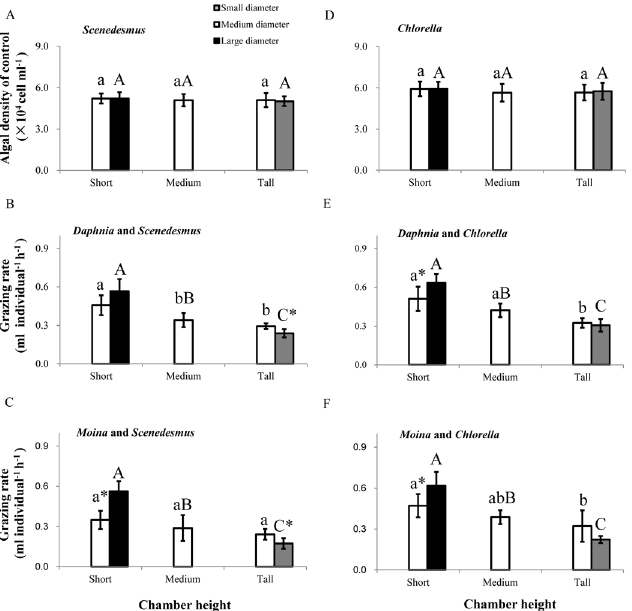
Fig 3. Algal density of Scenedesmus quadricauda and Chlorella vulgaris (control treatment), and the grazing rate of Daphnia magna and Moina micrura on these two algae. (A) Algal density of S . quadricauda ; (B) grazing rate of D . magna on S . quadricauda , and (C) of M . micrura on Scenedesmus ; (D) algal density of Chlorella vulgaris ; (E) grazing rate of D . magna on C . vulgaris , and (F) of M . micrura on C . vulgaris . Different lowercase letters indicate significant chamber height effect among treatments at a given base diameter. Different upper case letters indicate significant chamber shape effect at a given chamber volume. “ * ” indicates a significant difference between two treatments at a given chamber height. Data are presented as means ± s.d (n =